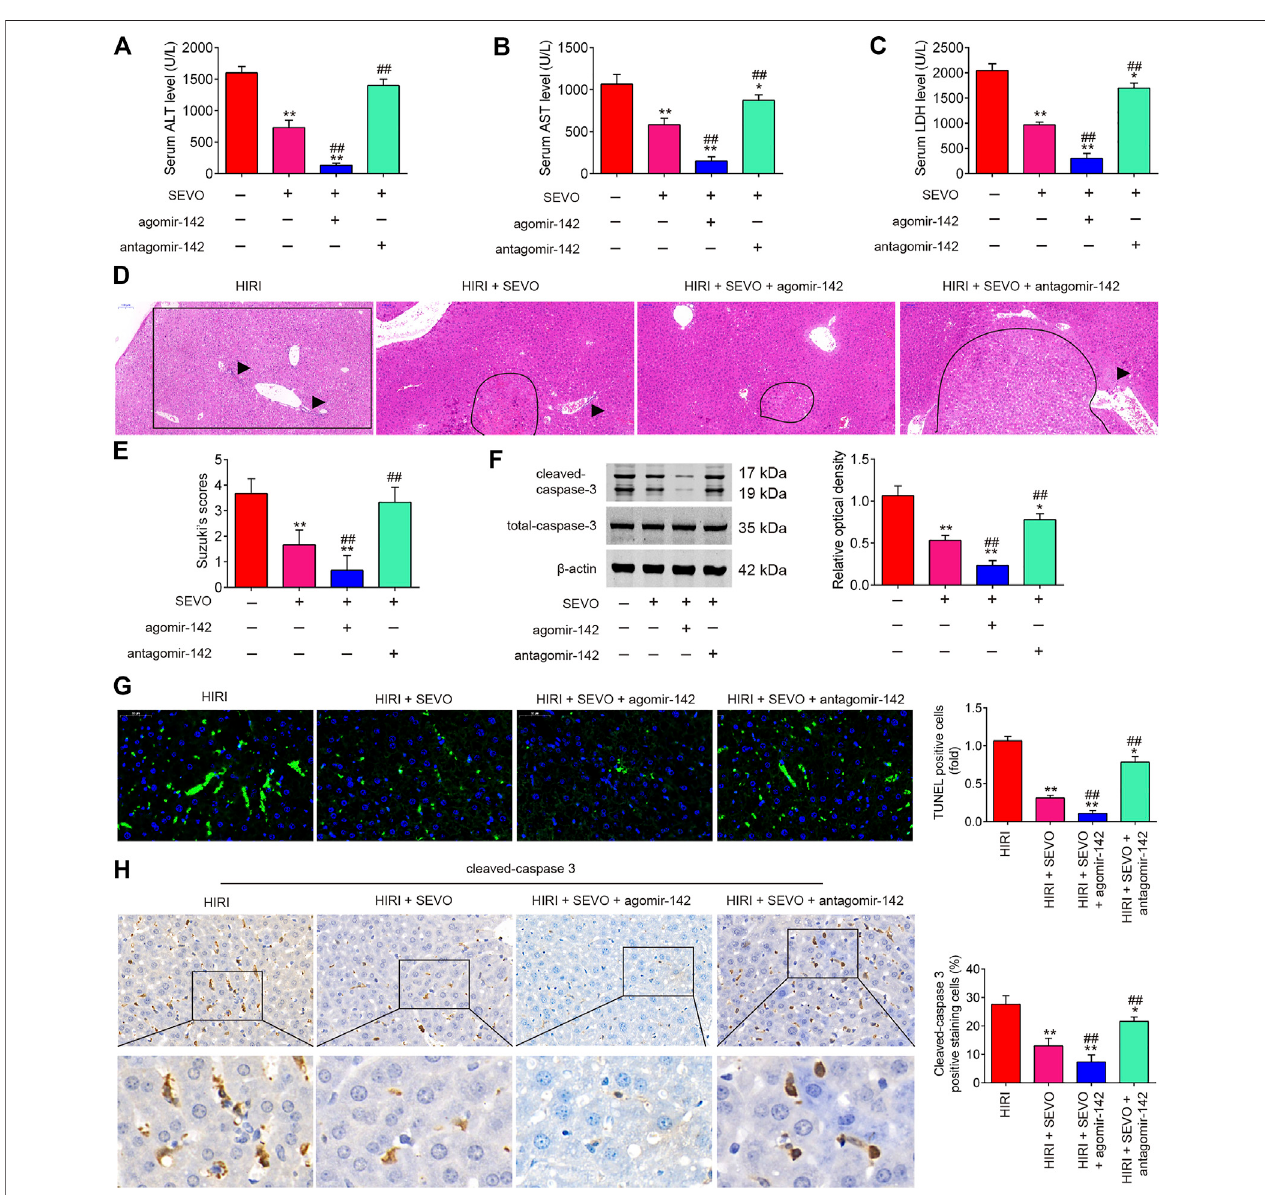
FIGURE 4 | Sevo fl uranepostconditioningdecreaseshepaticI/RinjurythroughregulationofmiR-142.TheagomiR-142andantagomiR-142wereinjectedintomice( n (cid:2) 6/ group),andthenthemiceweresubjectedtoischemia,post-treatmentwithinhalationof2%Sevofor2 himmediatelyattheonsetofreperfusion. (A – C) Liverenzymeassayswere performedinthefourgroups:HIRI,HIRI+Sevo,HIRI+Sevo+agomiR-142,andHIRI+Sevo+antagomiR-142groups( n (cid:2) 6/group)(A:SerumALTlevels;B:SerumASTlevels;C: SerumLDHlevels). (D,E) HepatictissuesofmiceineachgroupexaminedbyHEstainingandwasgradedusingtheSuzukiscore.Thein fl ammatorycellin fi ltrationisindicated withblackarrowandnecroticareasisindicatedwithcurve. (F) Theexpressionofcleavedcaspase-3wasdetectedbyWesternBlot. (G) TheapoptosiswasdeterminedbyTUNEL staining assay. (H) The expression of caspase-3 wasmeasured by IHC. All datawere measurementdata which wereexpressed as mean ± standard deviation and analyzed by one-way analysis of variance. * p < 0.05, ** p < 0.01 vs. HIRI group; ## p < 0.01 vs. HIRI + Sevo